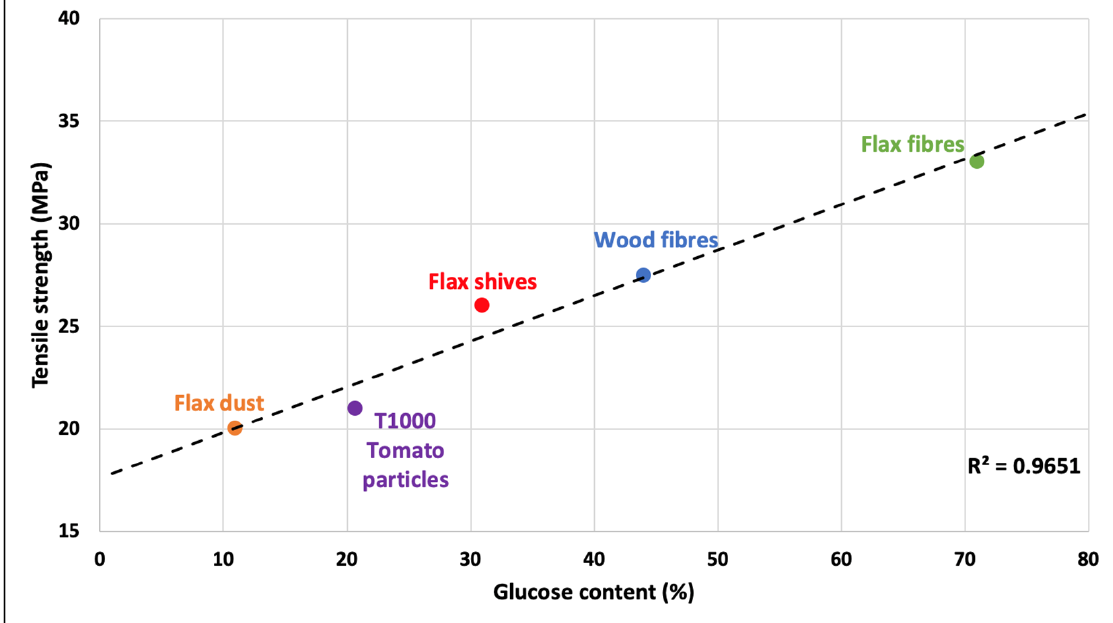
Figure 6. Correlation between the tensile strength and the glucose content of the reinforcement. All the blends have been produced with the same polymer (PP-g-MA) and same fiber weight fraction (30%) [2].